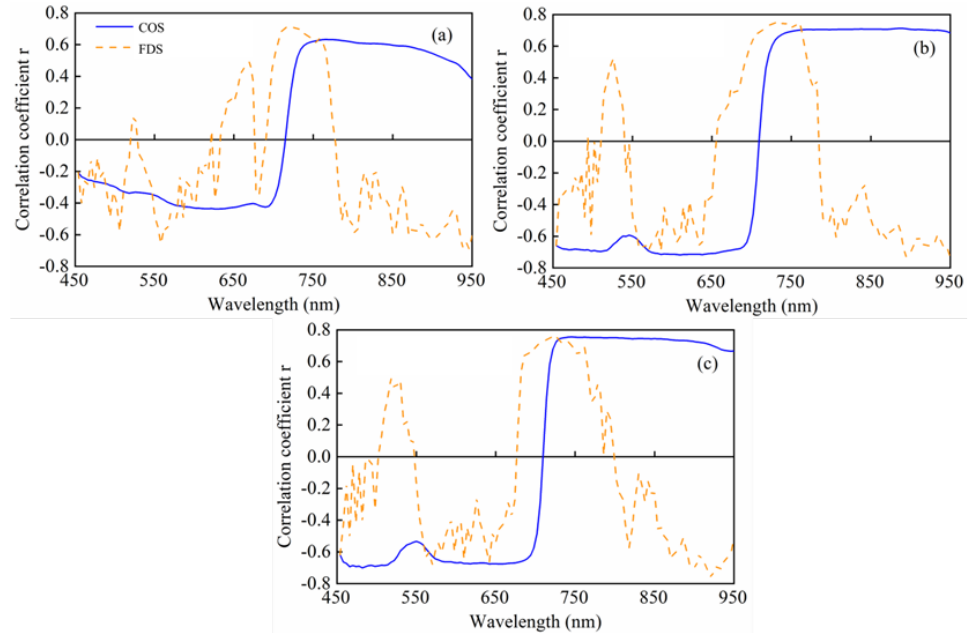
Figure 3. Correlation of canopy original spectra (COS) and first-derivative spectra (FDS) with above-ground biomass (AGB) of potatoes at different growth stages: ( a ) tuber-formation stage, ( b ) tuber-growth stage, ( c ) starch-storage stage.